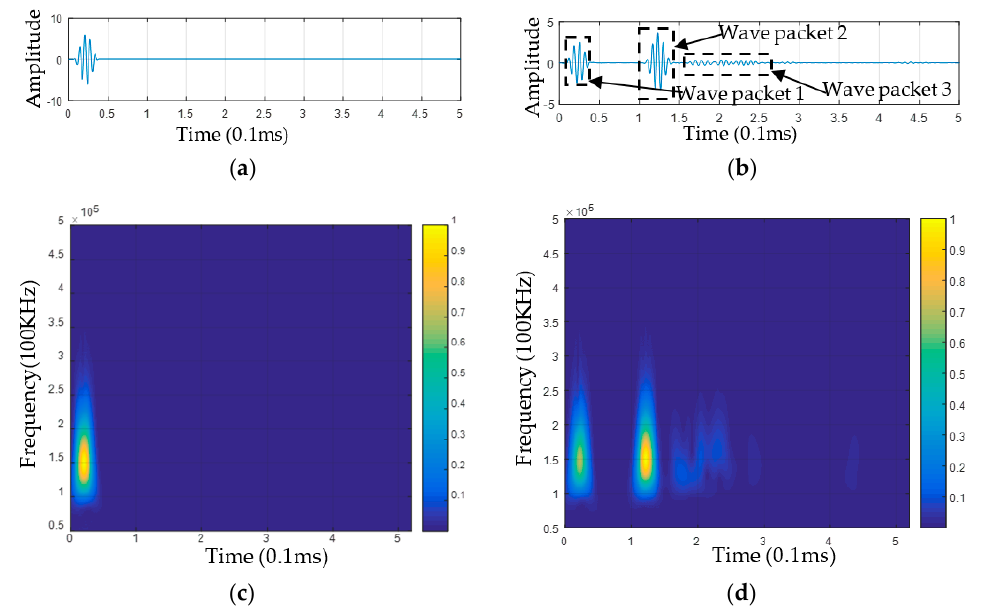
Figure 2. Lamb wave excited in the plate structure and the associated wavelet transform. ( a ) Excitation signal; ( b ) Plate structure response signal; ( c ) Time-frequency image of the wavelet transform of the excitation signal; ( d ) Time-frequency image of the wavelet transform of the plate structure response signal.